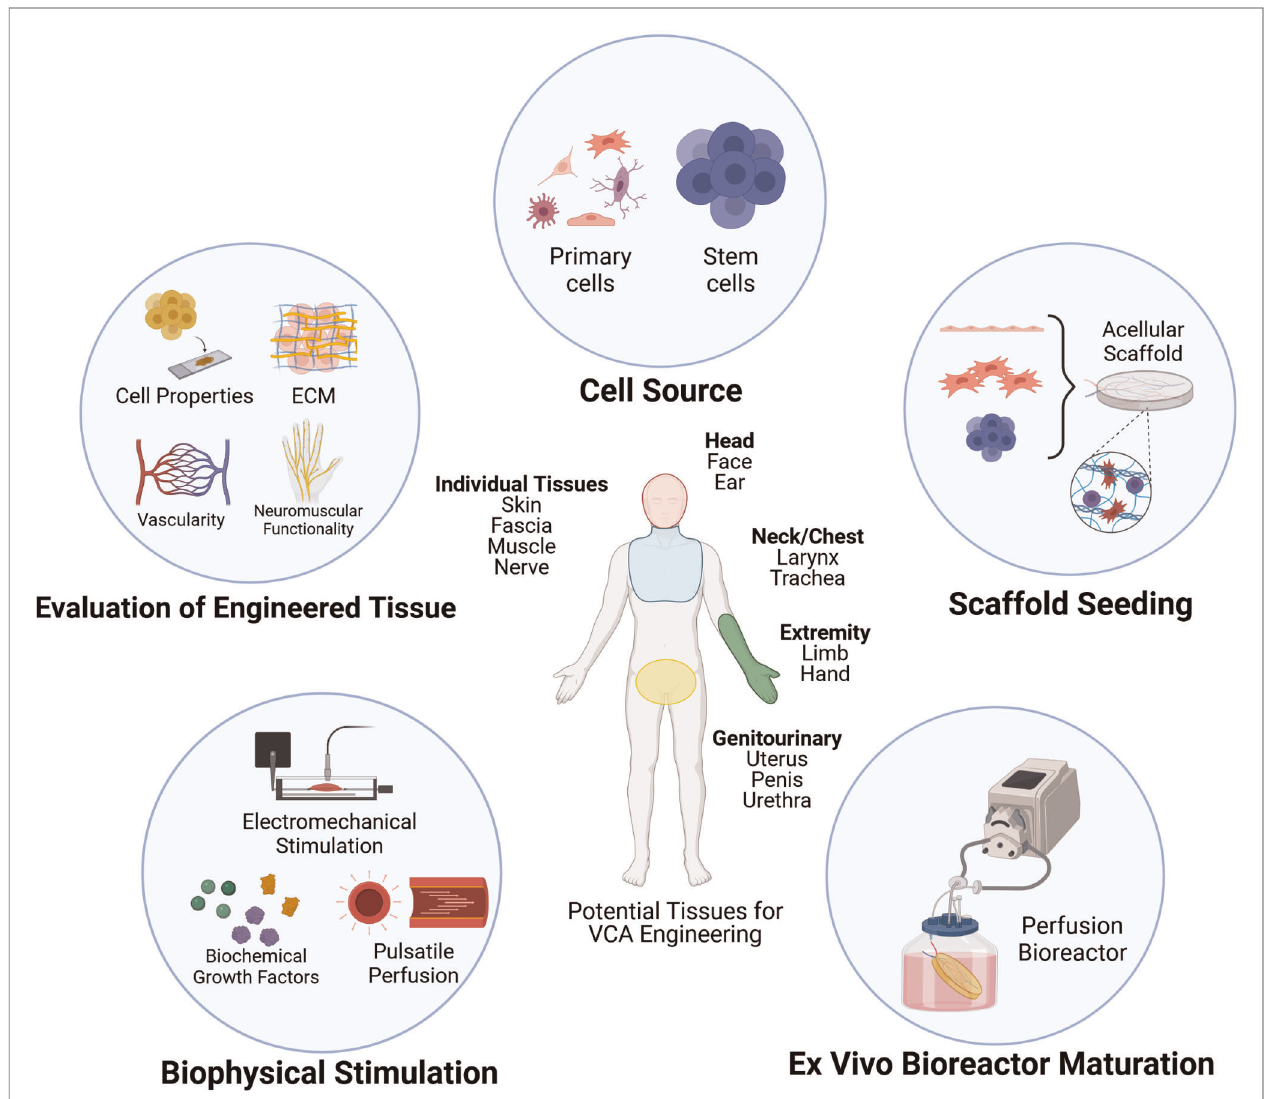
FIGURE 1 | Approaches and considerations for recellularization of vascularized composite allografts (VCA). Figure created in ©BioRender — biorender.com (Toronto,